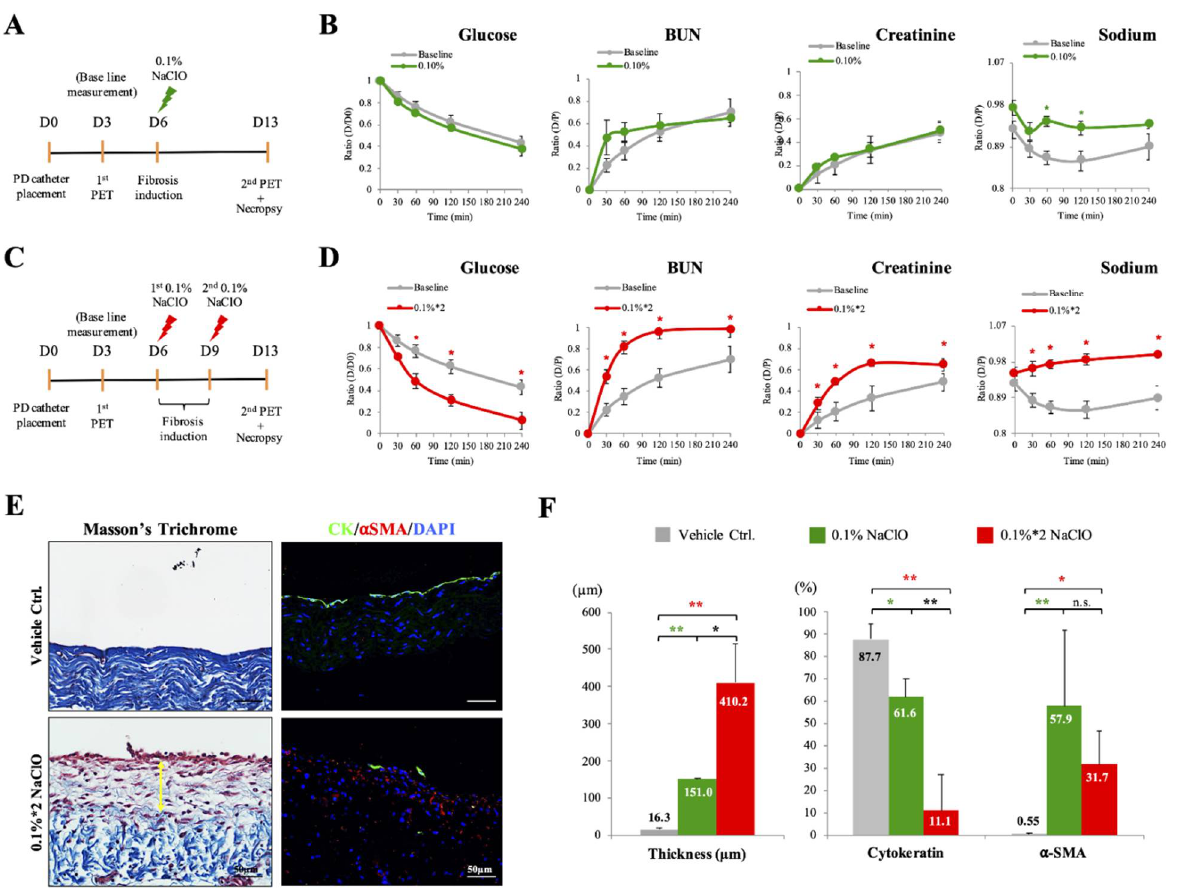
Figure 1. Histological and functional evaluations on peritoneum in NaClO-injured pig models. ( A ) Experimental schedule of single NaClO injection-induced peritoneal fibrosis. ( B ) PET results of a single 0.1% NaClO injury model showed minor differences in D/P sodium but no difference in D/P glucose, D/P urea, and D/P creatinine after a single 0.1% NaClO injection when compared to baseline PET (in grey). ( C ) Experimental schedule of twice NaClO injections-induced peritoneal fibrosis. ( D ) PET results of twice 0.1% NaClO injury model showed significant differences in all parameters measured, D/P glucose, D/P urea, D/P creatinine, and D/P sodium values measured in NaClO injury animals were significantly different from baseline values. ( E ) Significant thickening (yellow double arrow) of parietal peritoneum was observed on Masson’s trichrome staining after two injections of 0.1% NaClO. Fragmentation of mesothelium (labeled with CK in green) and infiltration of myofibroblasts (labeled with α-SMA in red) was also observed. ( F ) Quantitative analyses showed significant thickening of the peritoneum, loss of mesothelial cells, and accumulation of myofibroblasts under both injury models by 0.1% NaClO and 0.1%*2 NaClO. Representative images from 3 individual pigs of each group were presented. Asterisks indicated significant differences between groups (* p < 0.05, ** p < 0.01, N.S. not statistical different).